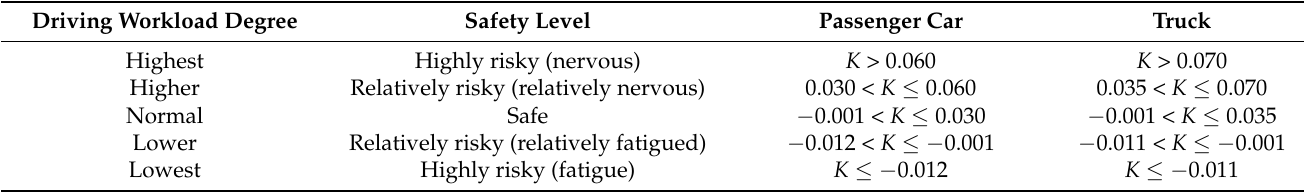
Table 3. Threshold values of the safety classification of driving workload on a freeway.